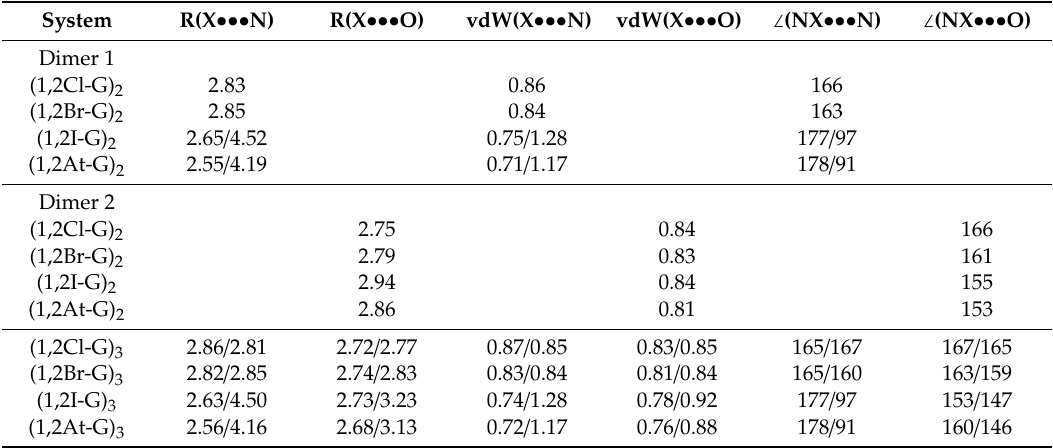
Table 4. Selected geometrical parameters (distances in Å; angles in degrees) and van der Waals ratios (vdW) for the R-II dimers and